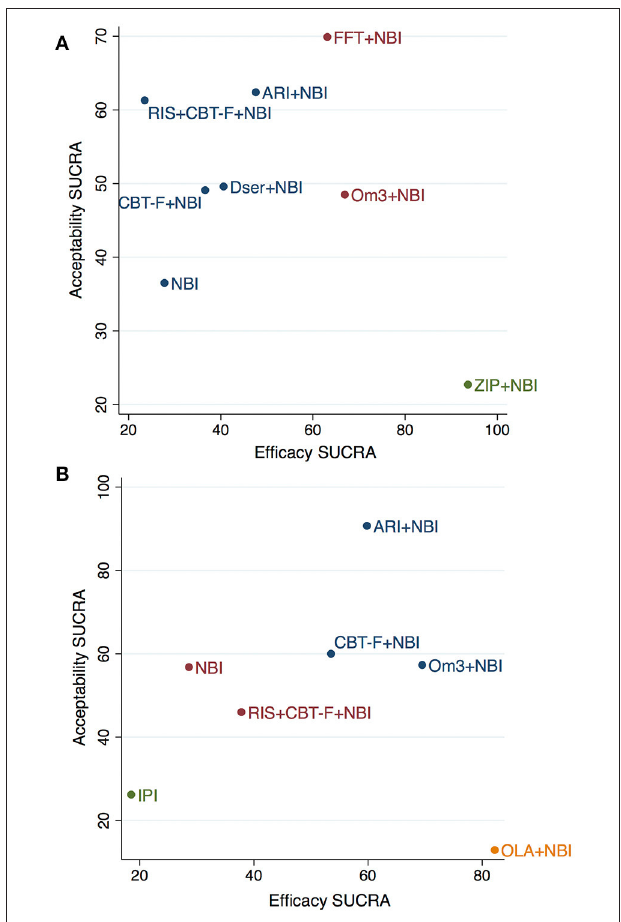
FIGURE 4 | Cluster-ranking of treatments according to SUCRA values for efficacy and acceptability at 6 (A) and 12 (B) months. Colors reflect treatments belonging to the same cluster. Please note that although the treatments have been ranked, there is no statistical difference between them -with the exception of ziprasidone + NBI for efficacy- (see Tables 3 , 4 for further details). ARI, aripiprazole; NBI, needs-based interventions (including placebo); CBT-F, cognitive behavioral therapy (French and Morrison protocol); Dser, D-serine; FFT, family-focused therapy; Om3, omega-3 fatty acids; RIS, risperidone;